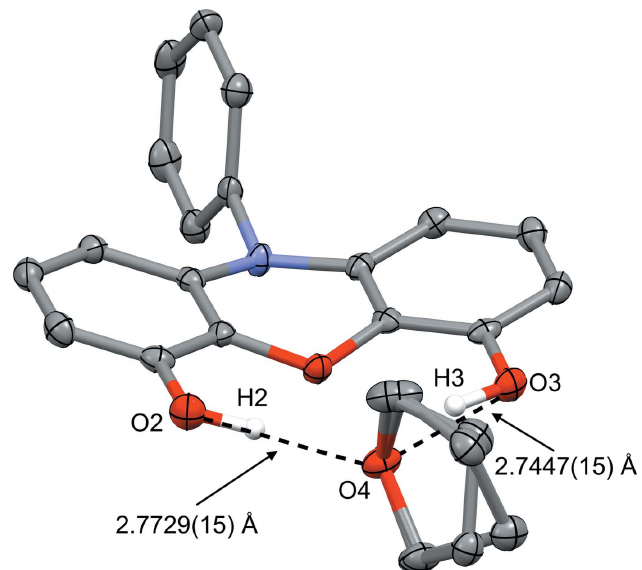
Figure 3 Solid-state structure of 10-phenyl-10 H -phenoxazine-4,6-diol, with disor- dered tetrahydrofuran solvate molecule (50% ellipsoids). Hydrogen- bonding interactions between the two hydroxyl groups and the oxygen atom of tetrahydrofuran are indicated by dashed lines.